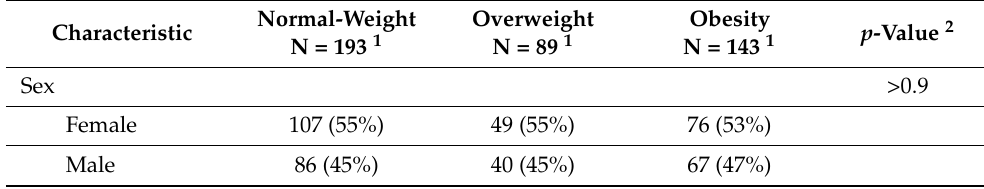
Table 1. Characteristics of 425 adolescents enrolled in the